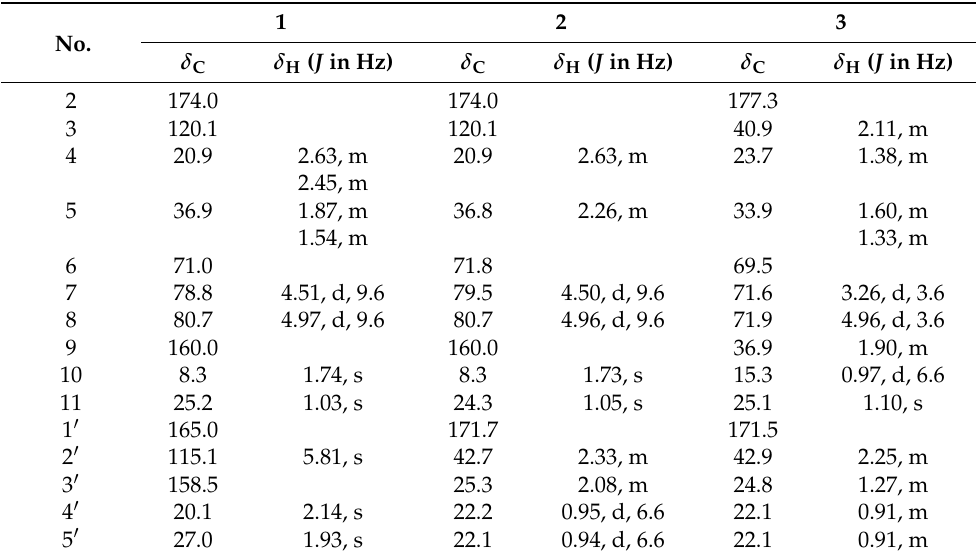
Table 1. 1 H (600 MHz) and 13 C-NMR (150 MHz) assignments of 1 – 3 (DMSO- d 6 ). No.